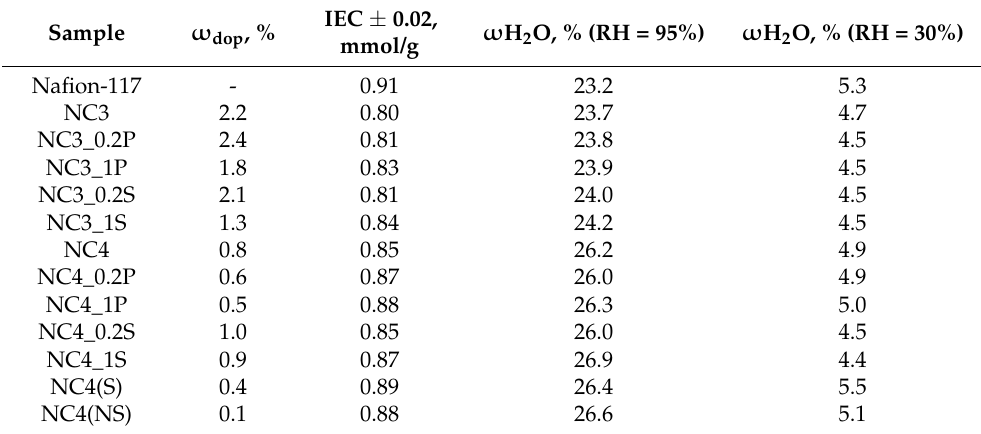
Table 2. Dopant content ( ω dop ), ion-exchange capacity (IEC) and water uptake ( ω H 2 O) at 95 and 30% RH of the prepared hybrid